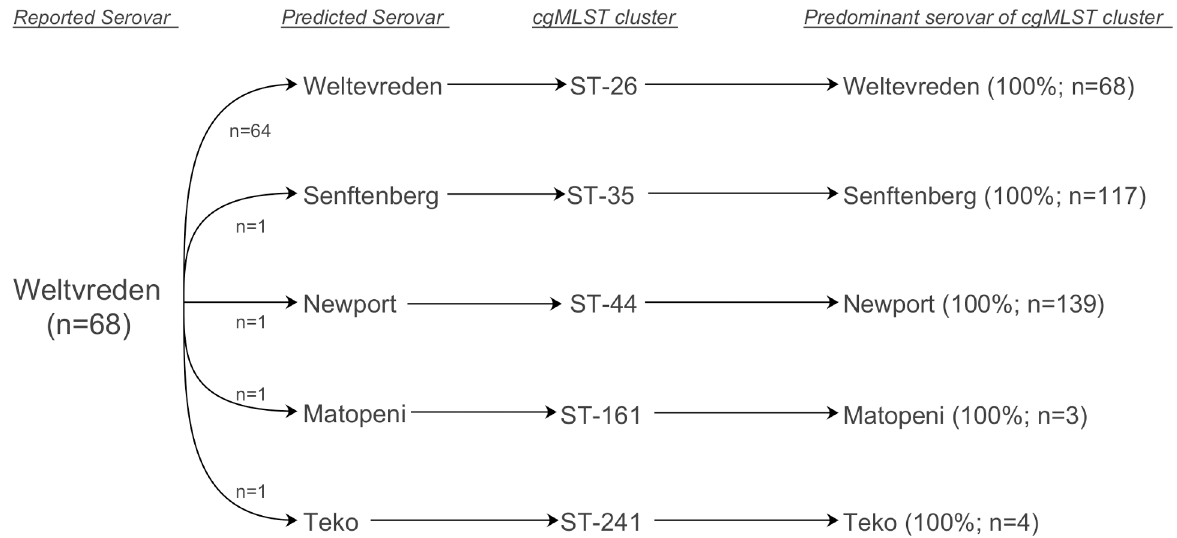
Fig 5. Differences between reported and predicted serovars for Weltevreden genomes are due to an incorrect reported serovar. While a large majority of genomes analyzed in the SISTR server were predicted as Weltevreden (n = 64), the remaining four genomes were predicted to have different serovars; these predictions matched the predominant serovar of their corresponding cgMLST cluster. The percent concordance between cgMLST and serovar and cgMLST cluster size are shown in